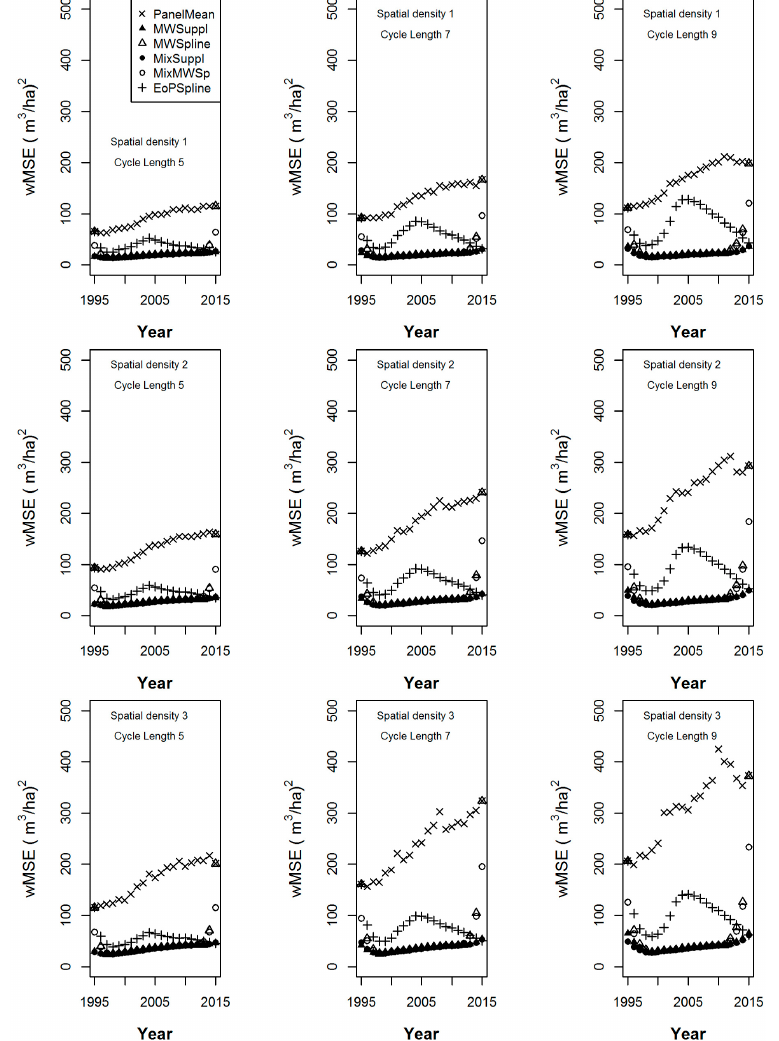
Figure 4. The weighted mean squared error of six volume estimators, the panel mean, the supplemented moving window, the splined moving window, the supplemented mixed estimator, the moving window-splined mixed estimator, and the splined EoP estimator from the simulation over the 152 populations under spatial sampling intensities 1 through 3 (top to bottom) and cycle lengths of 5, 7 and 9 years (left to right).